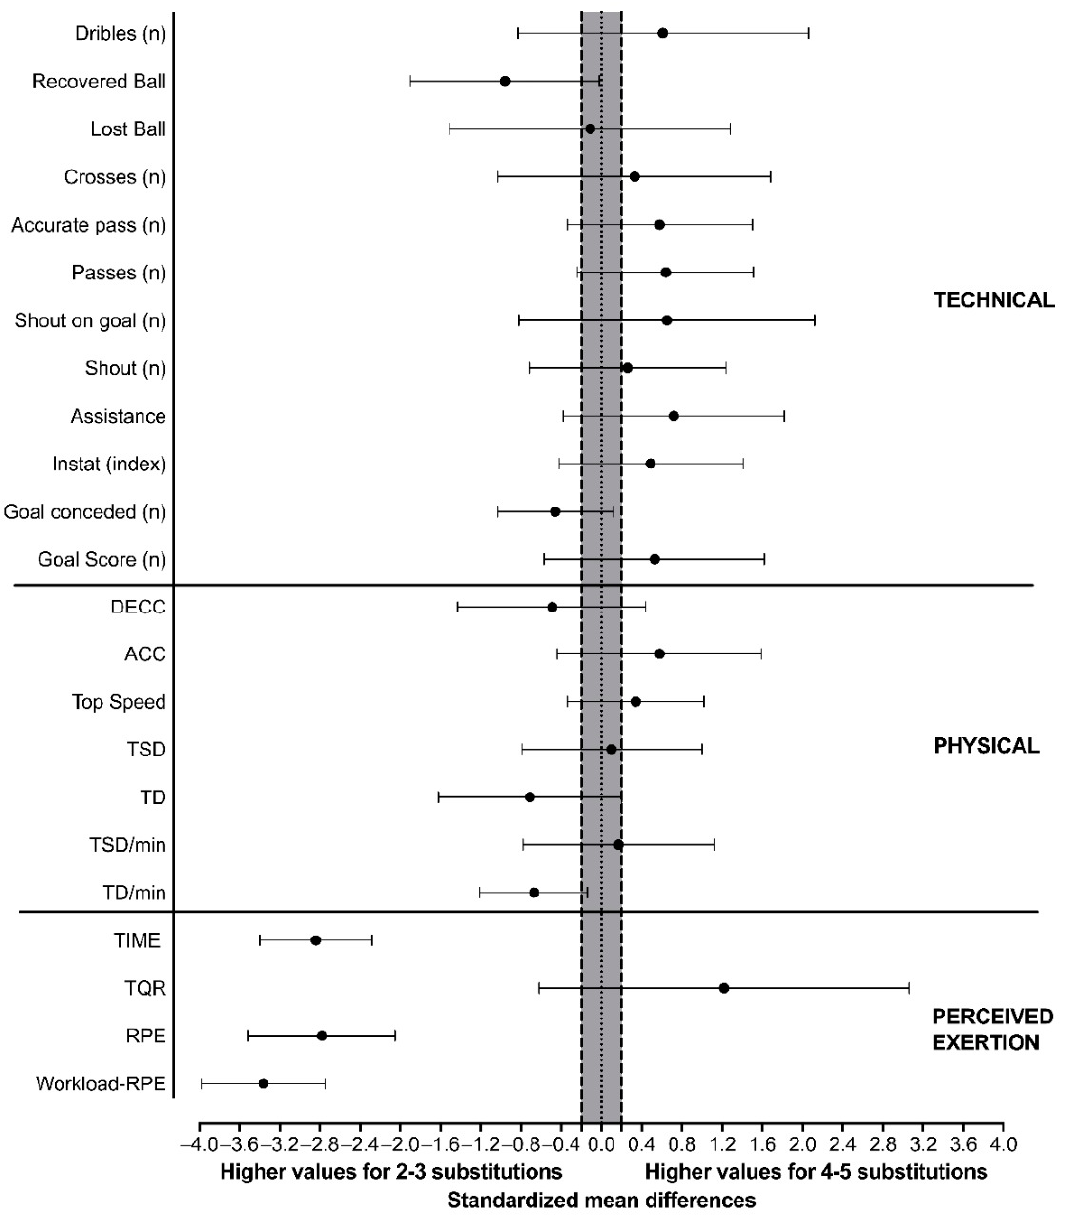
Figure 1. Standardized mean differences for the comparisons of the between substitutions conditions in all parameters of technical, physical, and perceived exertion; The grey area represents the smallest worthwhile difference which corresponds to a small effect size (0.2); Error bars represent the 95% confidence